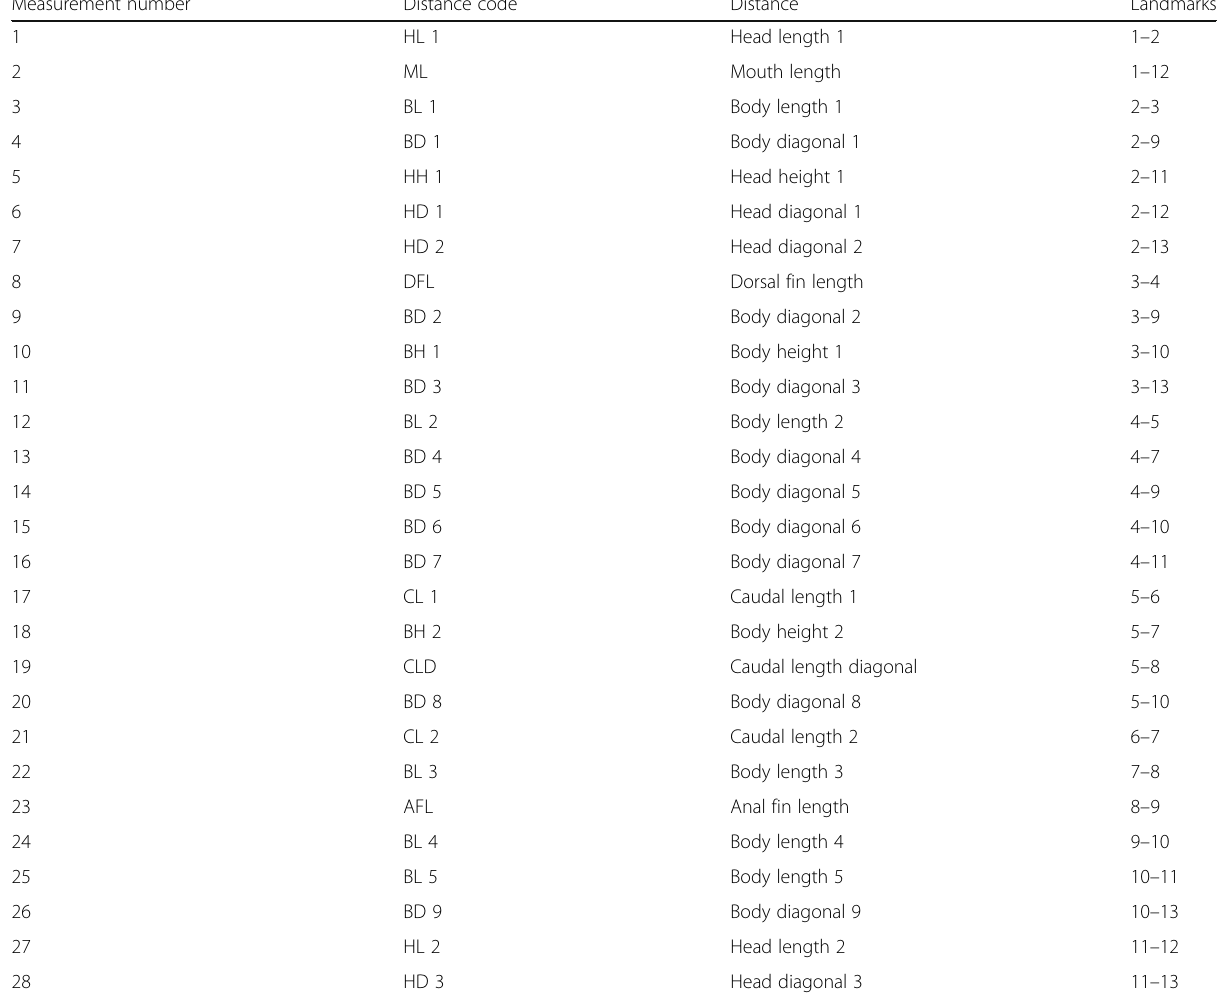
Table 2 Morphometric measurements made for each sample of A. clupeoides collected from the Bay of Bengal coast, Bangladesh Measurement number